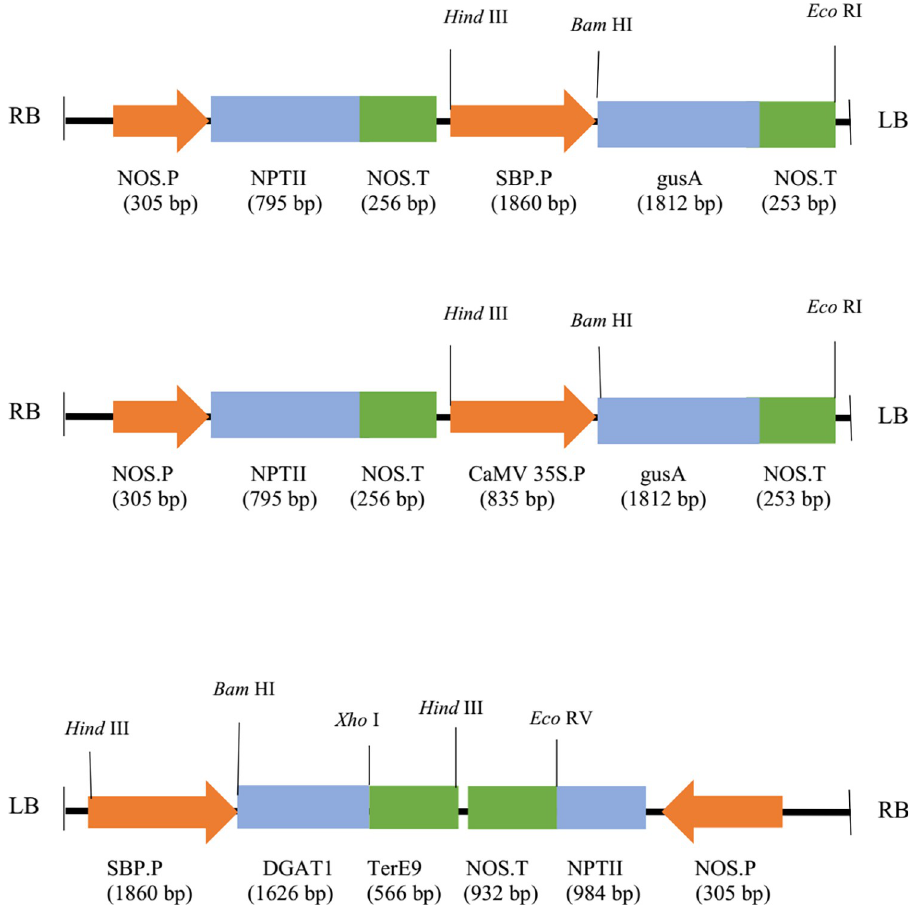
Fig 1. Construct maps: a. SBP- GUS b. 35S- GUS c . SBP- DGAT1; P. NOS: Nopaline synthase promoter; NPTII: Neomycin phosphotransferase gene; T. NOS: Nopaline synthase terminator; SBP.P: SBP promoter, gusA: β - glucuronidase gene; CaMV 35S.P: CaMV 35S promoter; DGAT1: Diacylglycerol acyl-CoA acyltransferase gene; TerE9: E9